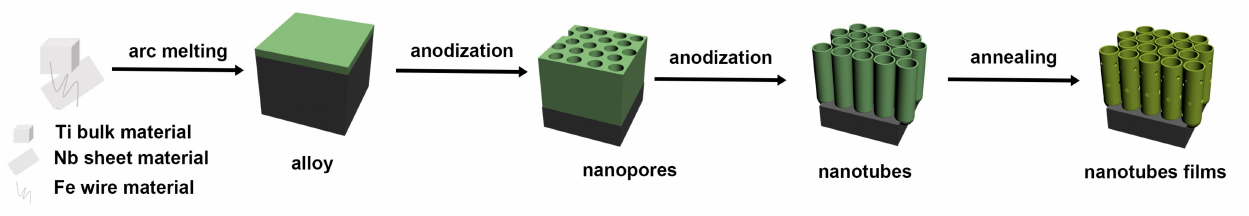
Figure 3. The synthesis diagram of Ti-Nb-Fe-O nanotubes.